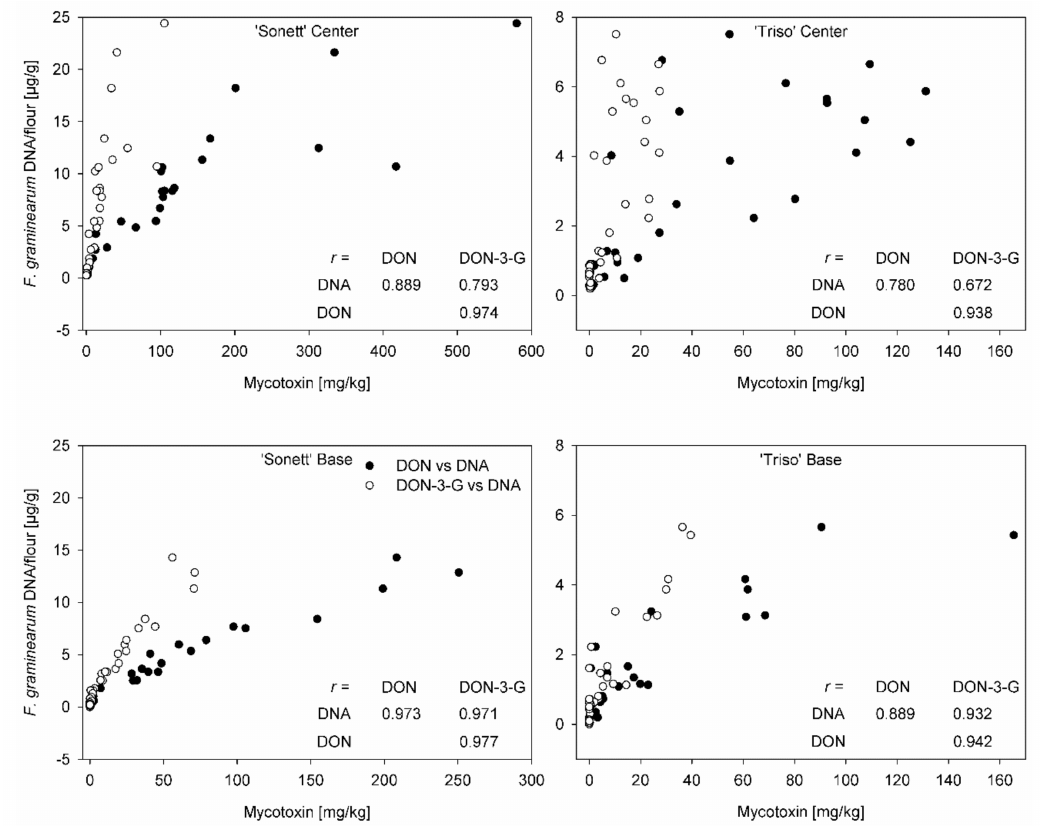
Figure 6. Pearson’s correlation coefficient between fungal DNA and deoxynivalenol, fungal DNA and deoxynivalenol-3- glucoside, deoxynivalenol and deoxynivalenol-3-glucoside in the bases and centers of the spikes of spring wheat varieties ‘Sonett’ and ‘Triso’ after inoculation of the central spikelets of the spike with Fusarium graminearum at different days after anthesis (daa) ( p ≤ 0.0001, n =